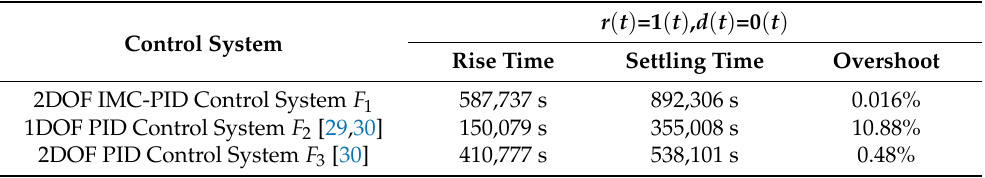
Table 2. Performance of three control systems without disturbance input. Control System